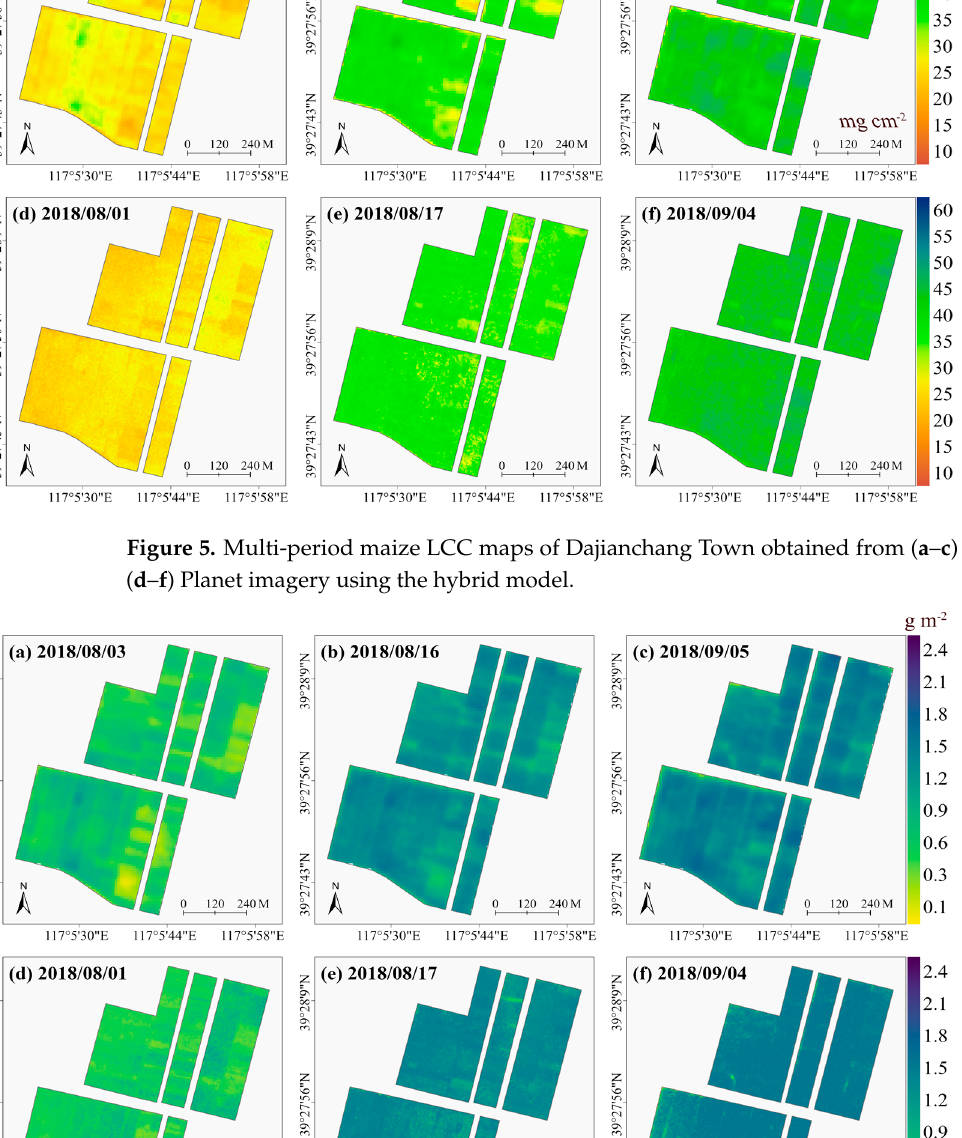
Figure 7. Maize LCC maps of Youyi farm obtained from Sentinel-2 imagery on ( a ) 3 July, ( b ) 13 July, ( c ) 28 July, ( d ) 17 August, ( e ) 1 September and ( f ) 14 September 2021 using the hybrid model.